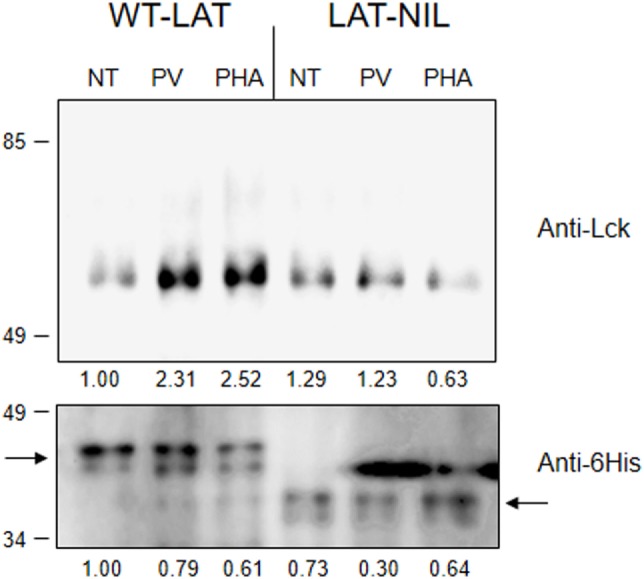
The negatively charged stretch of linker for activation of T cell (LAT) mediates interaction with Lck. 107 J.CaM2 cells expressing either WT-LAT or the LAT-NIL mutant were left untreated (NT) or stimulated for 5 min with 5 µM pervanadate (PV) or 20 µg/ml of PHA, and postnuclear lysates were subjected to LAT immunoprecipitation with an anti-LAT antibody. The precipitates were analyzed by Western blot with anti-Lck antibody (upper panel) or anti-6His antibody (lower panel), as indicated. Images are representative of three independent experiments. Numbers below the blots indicate the densitometric quantification of the corresponding bands.